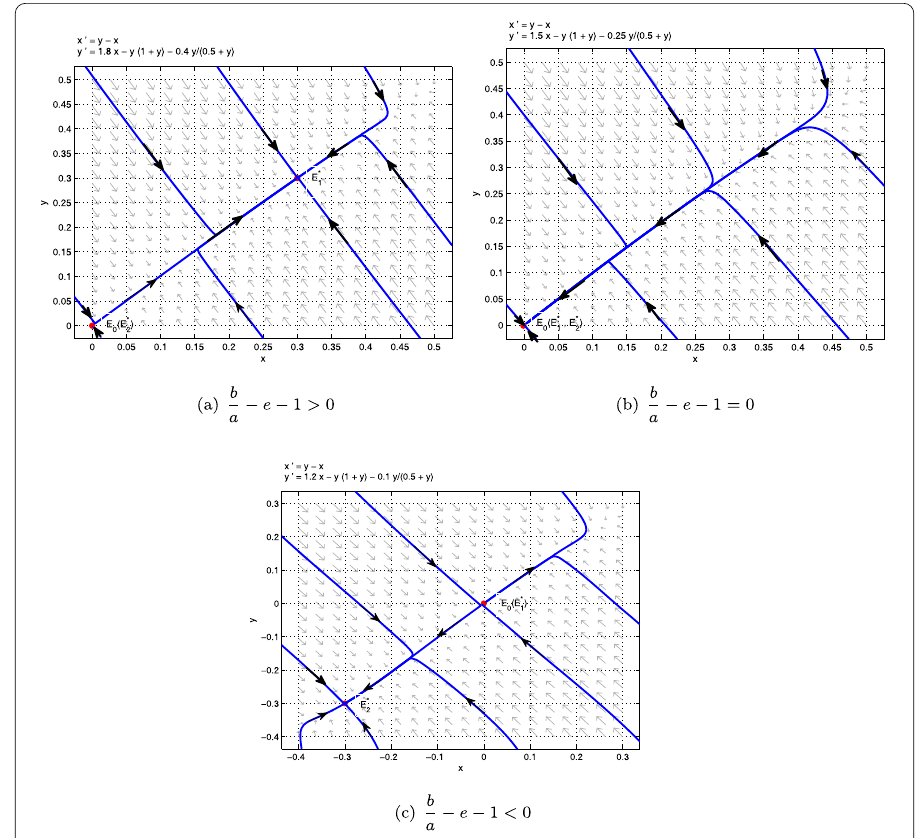
Figure 2 The phase portraits of transcritical bifurcation of system (1.7) when c = c